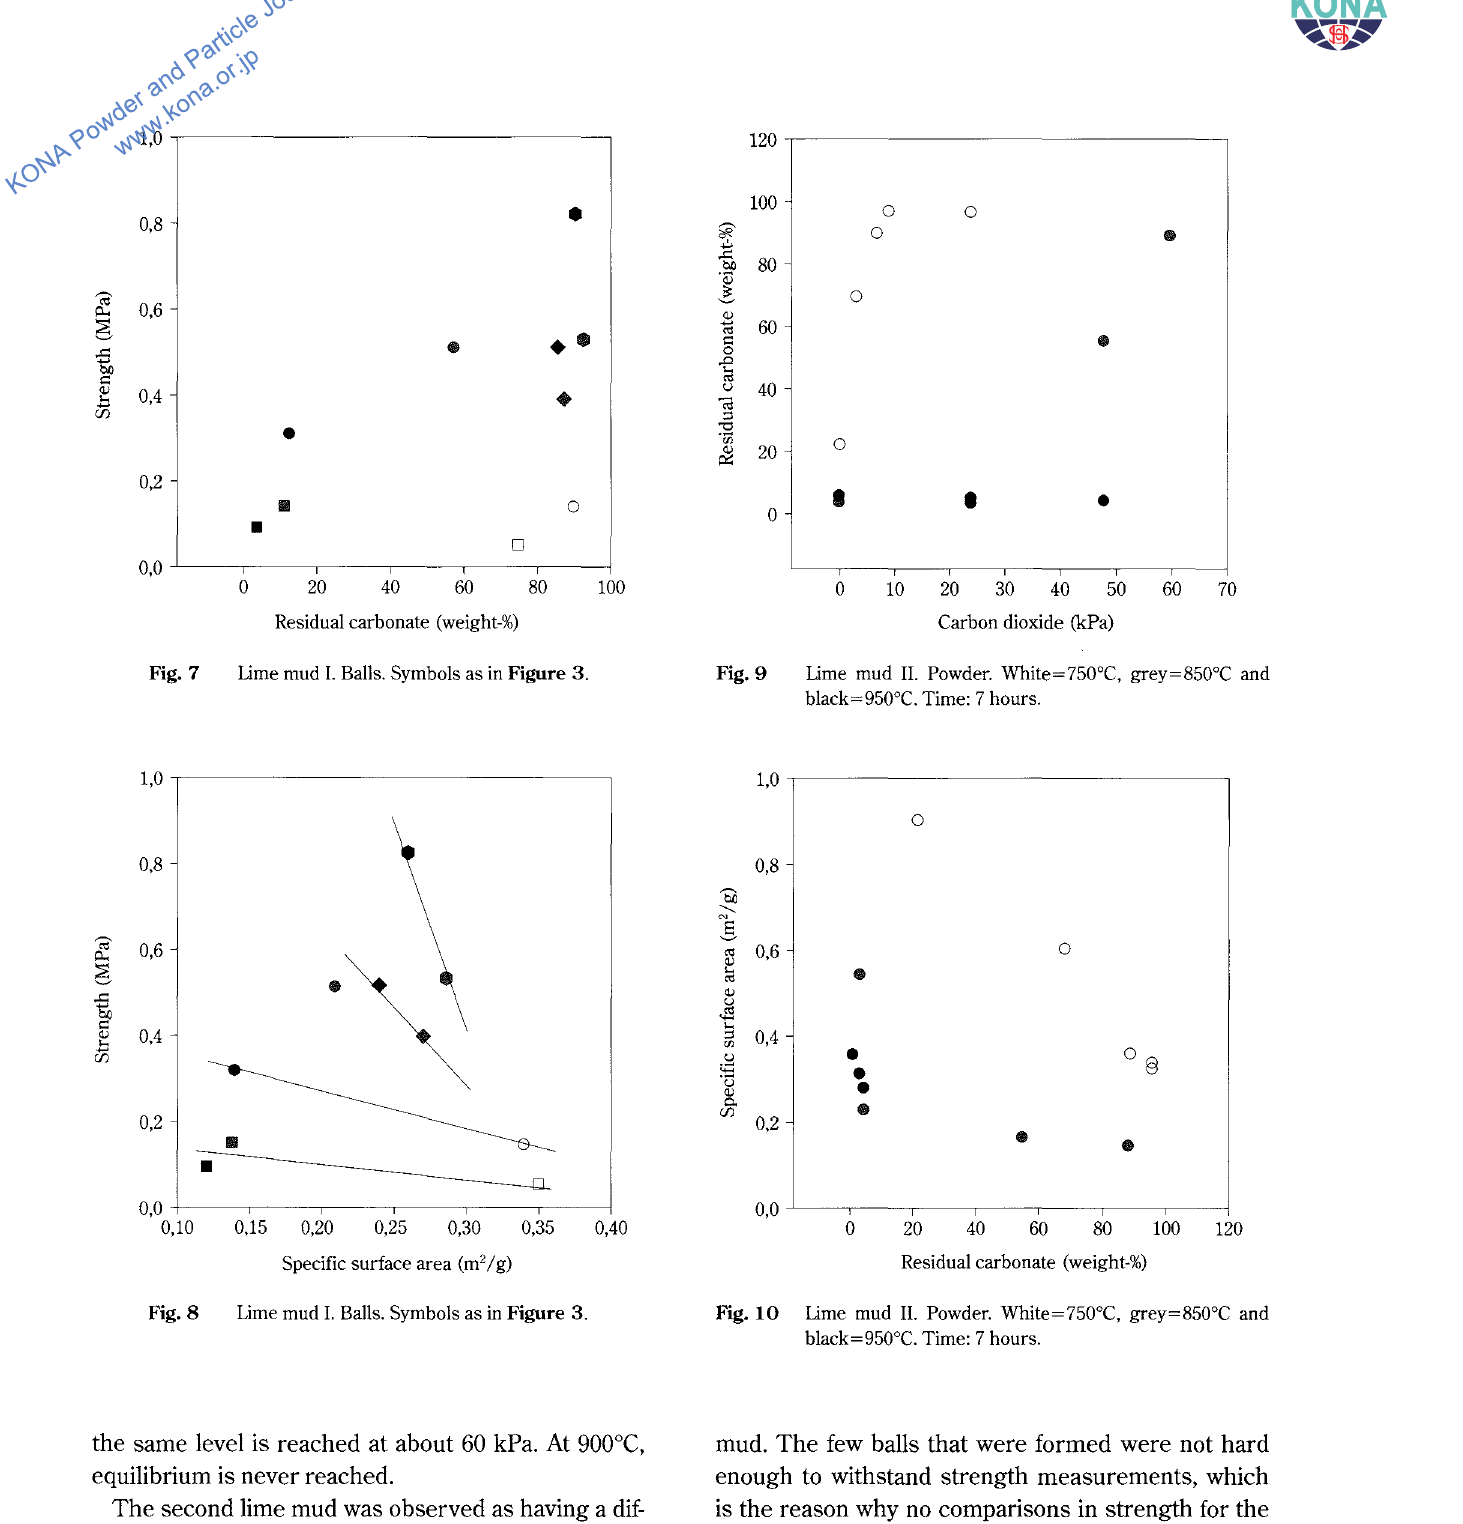
Fig. 10 Lime mud II. Powder. White=7500C, grey=850°C and black=950°C. Time: 7